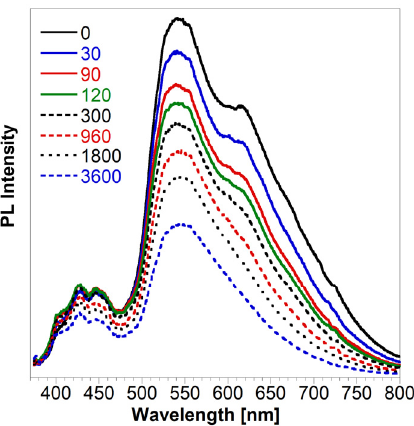
Figure 3 , where the emission spectra of the bare DCA-DPH:DBT:DBTT films are compared for increasing irradiation times.